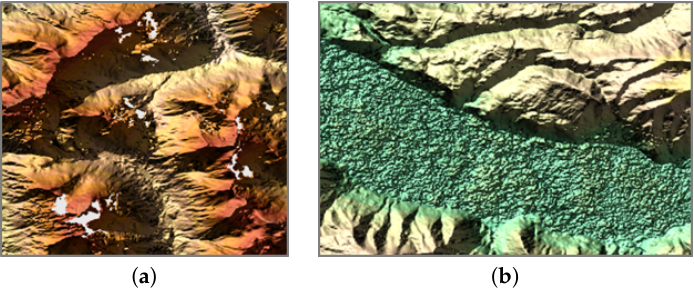
Figure 1. ( a ) Example of gaps still present in the global TanDEM-X Digital Elevation Model (DEM) over high-relief terrain (white) due to geometric distortions in the original data (shadow and layover), ( b ) example of an unedited noisy water